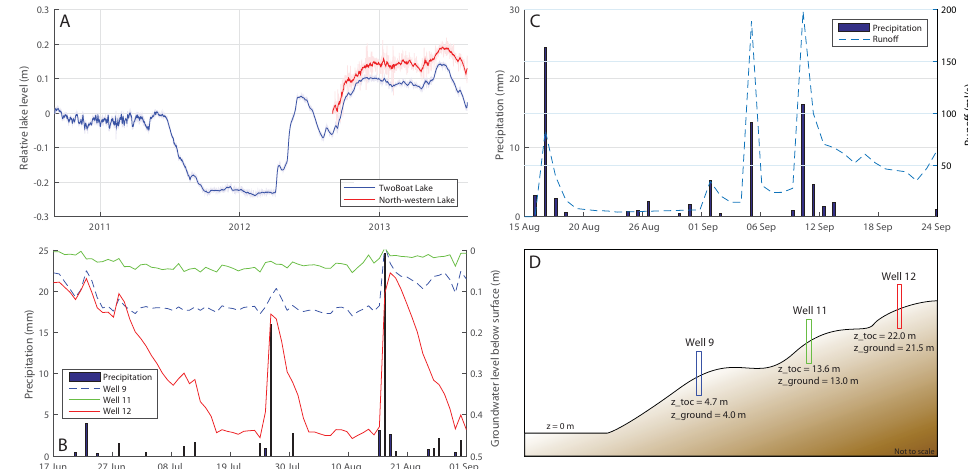
Figure 7. Lake level in TBL co-plotted with the lake level of the northwestern lake (a) and groundwater levels (b) along a transect (d) , co- plotted with precipitation data from the AWS. Measured surface water inflow, mLs − 1 , to the northern part of TBL in August and September 2013, co-plotted with measured precipitation in the AWS, mmday − 1 (c) .